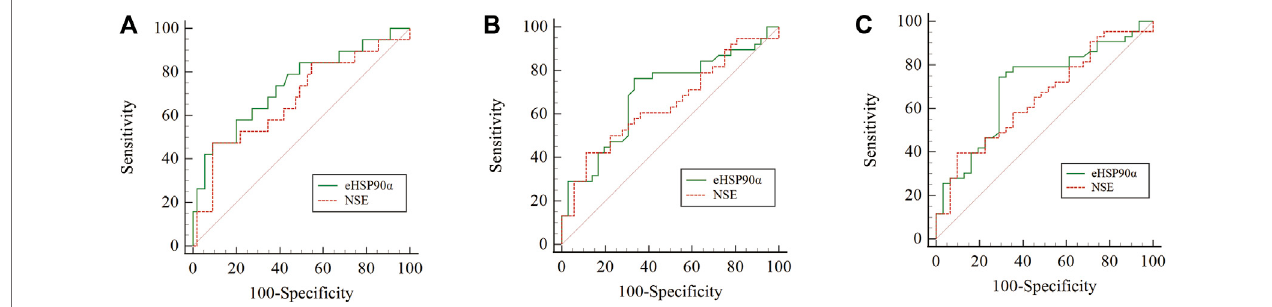
FIGURE 2 | Comparison of the areas under the ROC for outcome prediction among the three status-based prognostic scores (A) OS status p = 0.3545 (B) PFS status p = 0.5394 (C) RECIST status p = 0.5246.